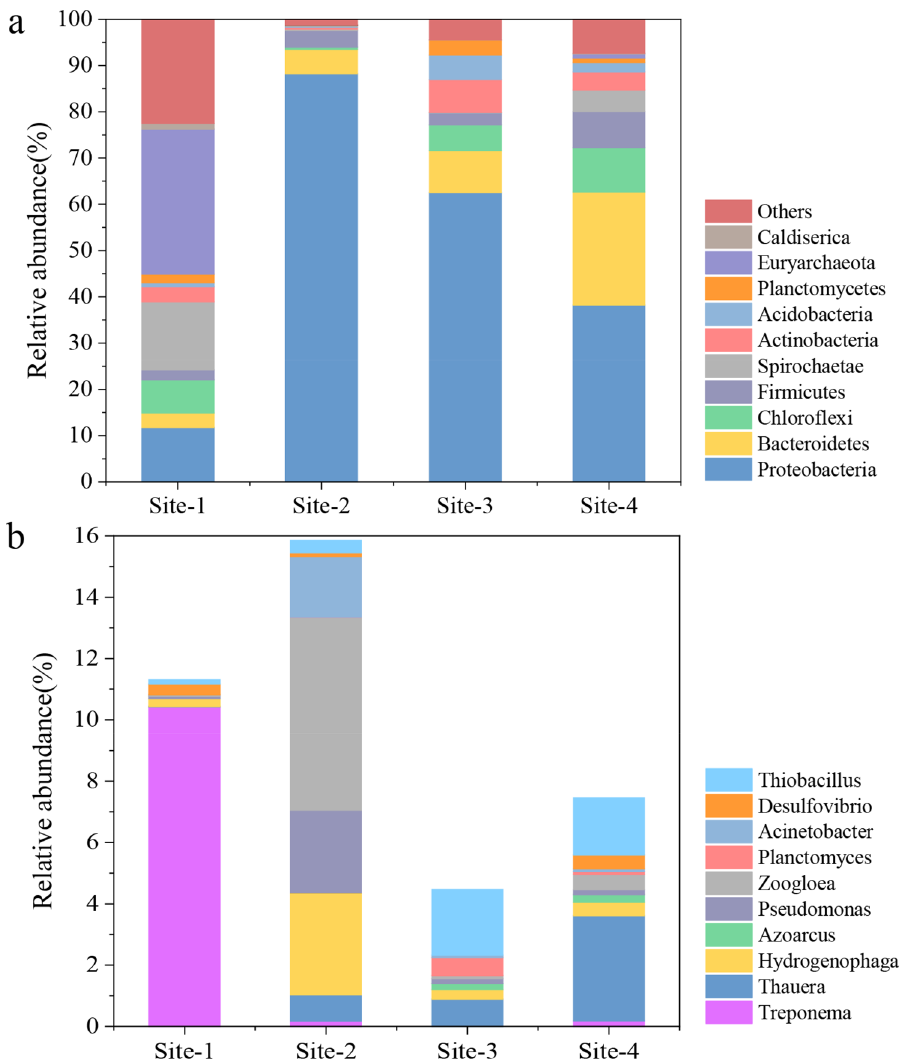
Figure 2. Microbial composition in four sites at the phylum ( a ) and genus ( b )